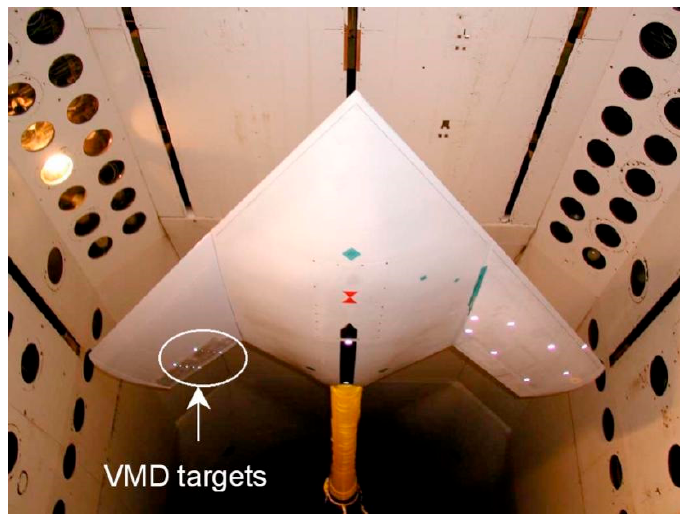
Figure 14. Video model deformation ( VMD) measurement system [54].